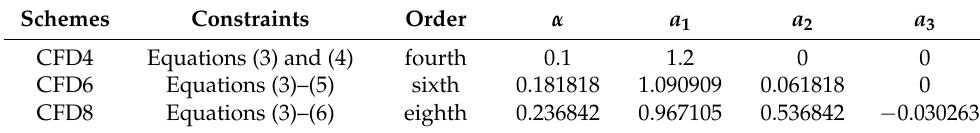
Table 1. Coefficients of the tridiagonal compact